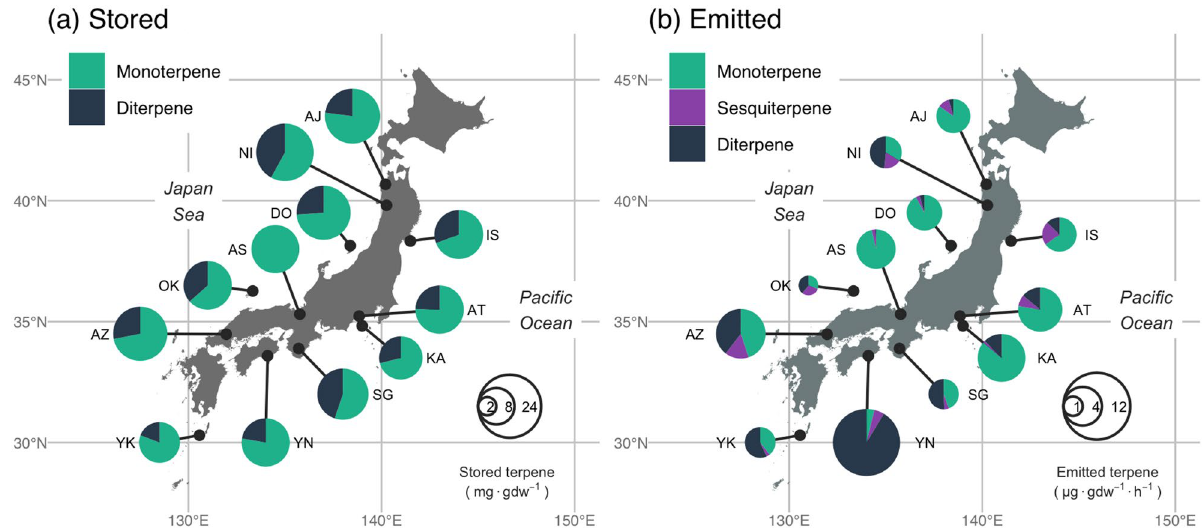
Figure 2. Stored ( a ) and emitted ( b ) terpenoids in C. japonica leaves grown in a common garden. The map was generated using GeoPandas (version 0.8.0; https:// geopa ndas. org) and matplotlib (version 3.3.4; https:// matpl